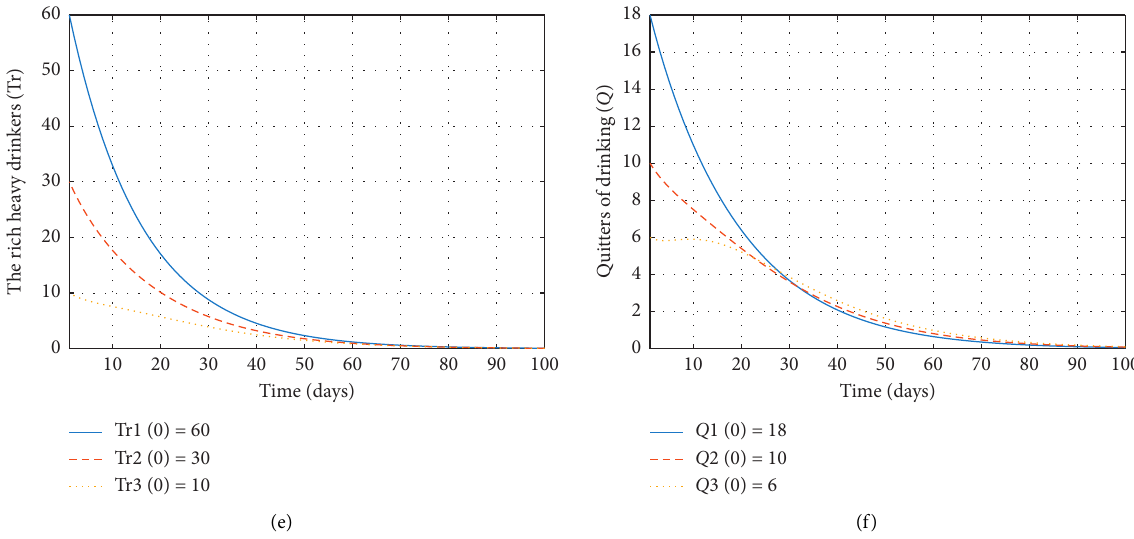
Figure 2: When R 0 < 1, the drinking-free equilibrium E 0 is globally asymptotically stable.